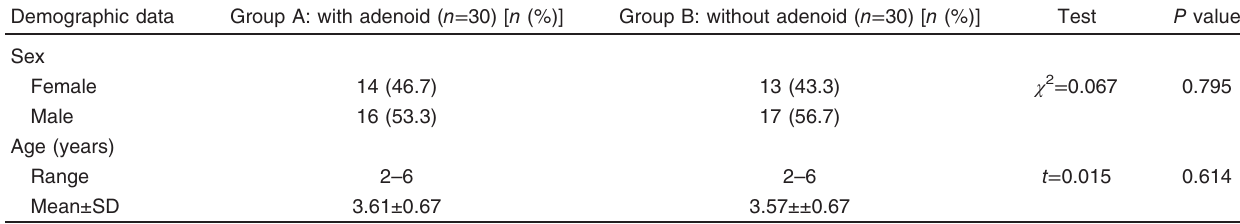
Table 4 Comparison between group A, with adenoid, and group B, without adenoid, according to demographic data Demographic data